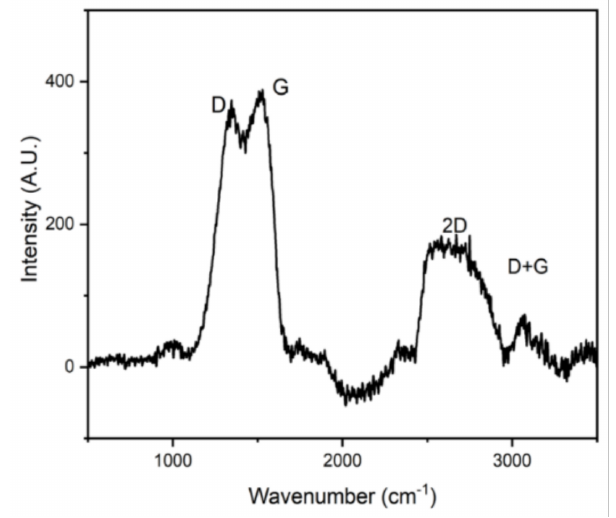
Figure 2. Micro-Raman spectroscopy measurements of the polymer-derived